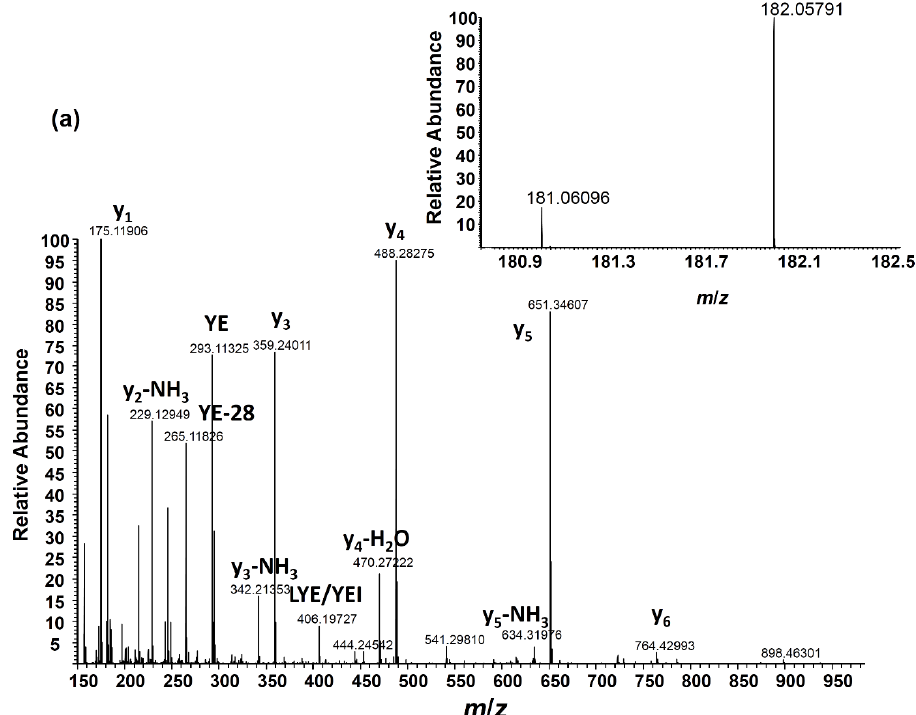
Figure 5. ( a ) HCD MS/MS spectrum of m / z 487.2 (+2 charge state), the nitropeptide, Y*LYEIAR, from BSA; ( b ) HCD MS/MS spectrum of m / z 745.5 (+2 charge state), the nitropeptide, Y*IC # DNQDTISSK, from BSA. Insets in both spectra show the expanded region containing the light and heavy nitrotyrosine reporter ion pair; and ( c ) Collision-induced dissociation CID MS/MS spectrum of m / z 745.5 used in the identification of Y*IC # DNQDTISSK by MaxQuant. * and # indicate nitration and carbamidomethylation,